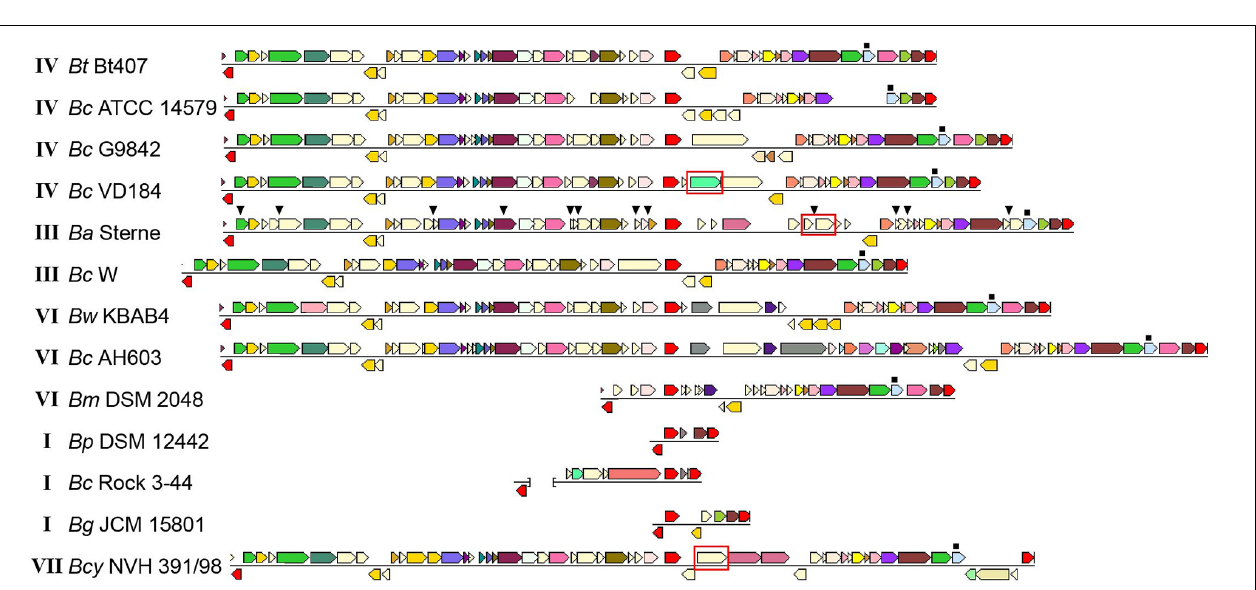
FIGURE 1 | Comparison of genomic loci encoding flagellar-based motility genes in Listeria monocytogenes, Bacillus thuringiensis and B. subtilis. Top: L. monocytogenes ( Lm ) EGD-e (single chromosomal locus). Middle: B. thuringiensis ( Bt ) 407 (two chromosomal loci). Bottom: B. subtilis ( Bs ) 168. The Bs 168 gene annotations are in accordance with gene or protein names for the corresponding RefSeq entries. Where orthologs to the Bs 168 genes are present in Bt 407 and/or Lm EGD-e, as determined by reciprocal best BLAST hits, these are given the same gene names, except for fliS , fliE , fliH , og hag / flaA/flaB (see Supplementary Table 1 ). Annotation for the following genes lacking Bs 168 orthologs is according to the specified references: mogR (Gründling et al., 2004), gmaR (Shen et al., 2006), flgE (NP_464224 and ZP_04138734), and fliN (ZP_04138744). Hypothetical genes in Lm EGD-e and Bt 407 are indicated by locus tags. Protein orthologs or blocks of colinear orthologs are indicated by identical coloring in two or three strains. Genes shown in white do not have orthologs in any of the two other strains.